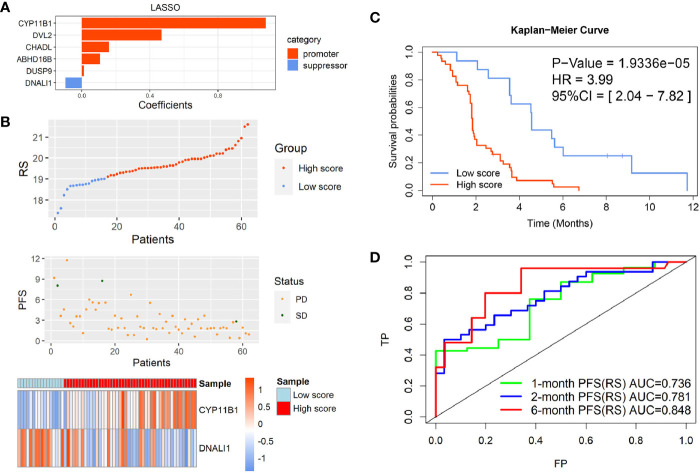
Identification of the two-gene prognostic signature-based risk score (RS) for EGFR-WT NSCLC patients. (A) Six robust markers obtained by LASSO regression. (B) The distribution of RSs in GSE31852. Top: two groups for EGFR-WT patients according to the best cut-off of risk score. Middle: relationship between RS (X-axis) and PFS time (Y-axis). Bottom: heatmap plot for the expression of genes in the two-gene signature. (C) Kaplan-Meier curve of PFS probability based on the RS in EGFR-WT NSCLC. (D) ROC curves were used to compare the predictive ability of the two-gene prognostic signature for 1, 2, and 6-month survival probabilities. PFS status: SD, stable disease; PD, progressive disease.